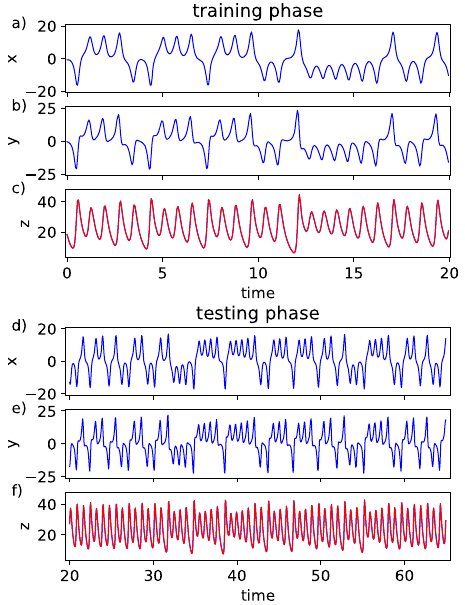
Fig. 4 Inference using an NG-RC. a – c Lorenz63 variables during the training phase (blue) and prediction ( c , red). The predictions overlay the training data in ( c ), resulting in a purple trace (NRMSE = 9.5 ± 0.1 × 10 − 3 using α = 0.05). d – f Lorenz63 variables during the testing phase, where the predictions overlay the training data in ( f ), resulting in a purple trace (NRMSE = 1.75 ± 0.3 × 10 − 2